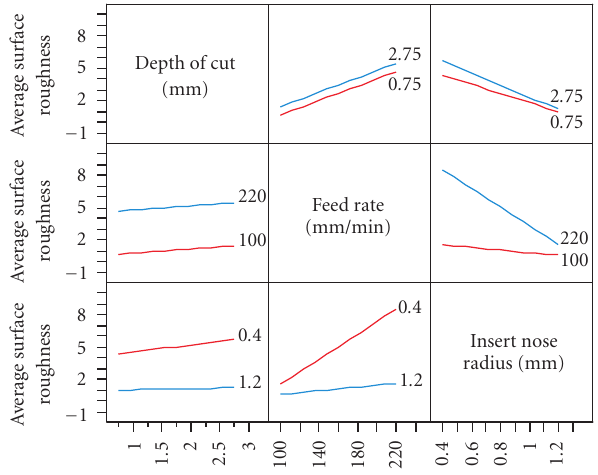
Figure 9: The interaction e ff ect plots of depth of radius, feed rate, and insert nose radius on the surface